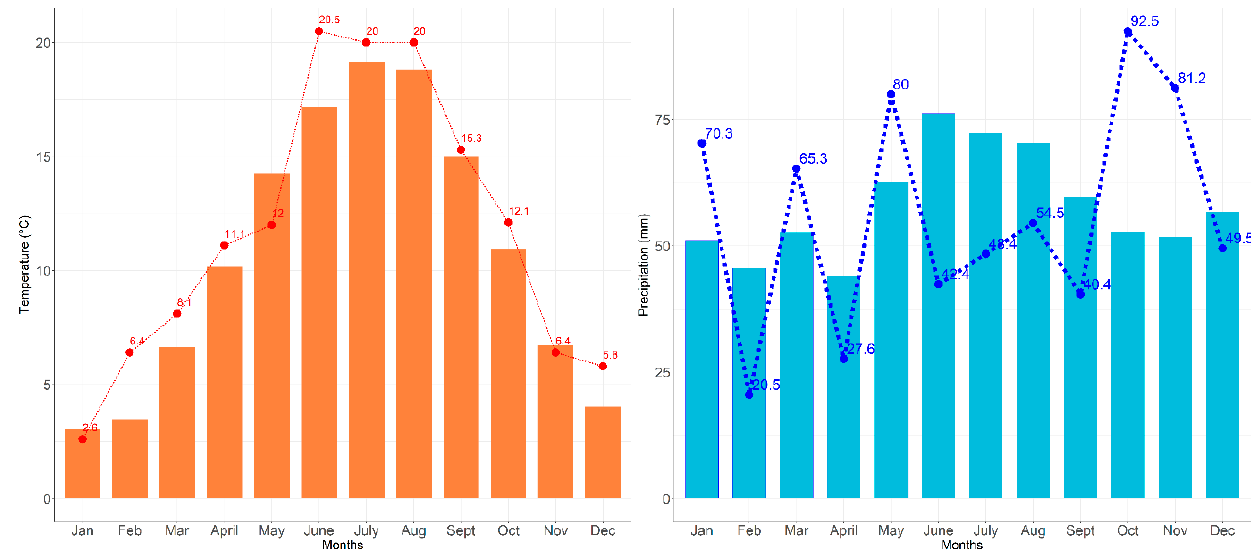
Figure 3. Mean monthly air temperature ( left panel) and precipitation ( right panel) from 1980 to 2019 (bars) and for 2019 (lines) at Dikopshof (source: interpolated data from the German Weather Service, DWD).